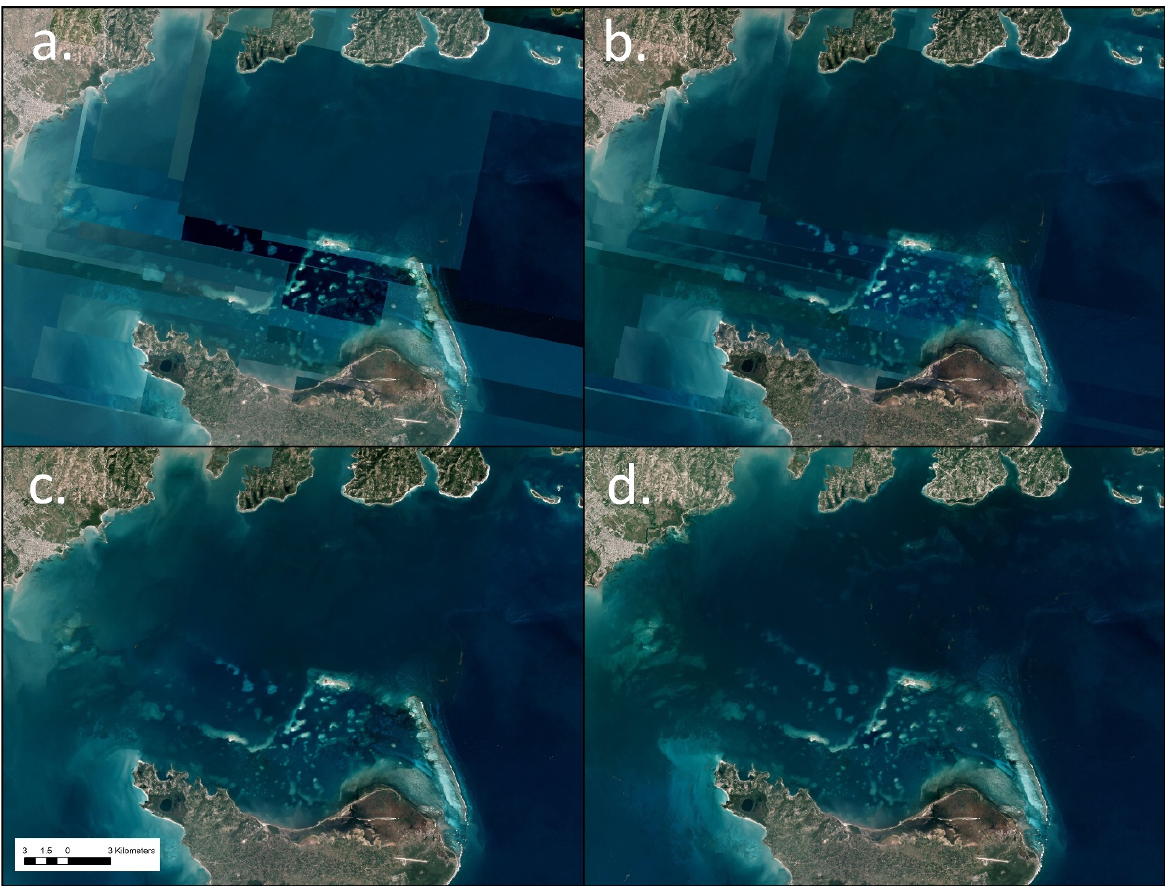
Figure 3. Example of corrections applied during image compositing in Île- à -Vache, Haiti: ( a ) Input surface reflectance data based on best quality scenes; ( b ) Normalization applied using MODIS reference data in addition to the physics-based atmospheric correction approach used in the PS surface reflectance scene product; ( c ) Seamline removal via a surface reconstruction method that smoothly shifts values near scene edges to match values at the boundary between scenes; ( d ) Manual quality control where the hand selection of scenes significantly reduced turbidity in near-coastal waters in the final